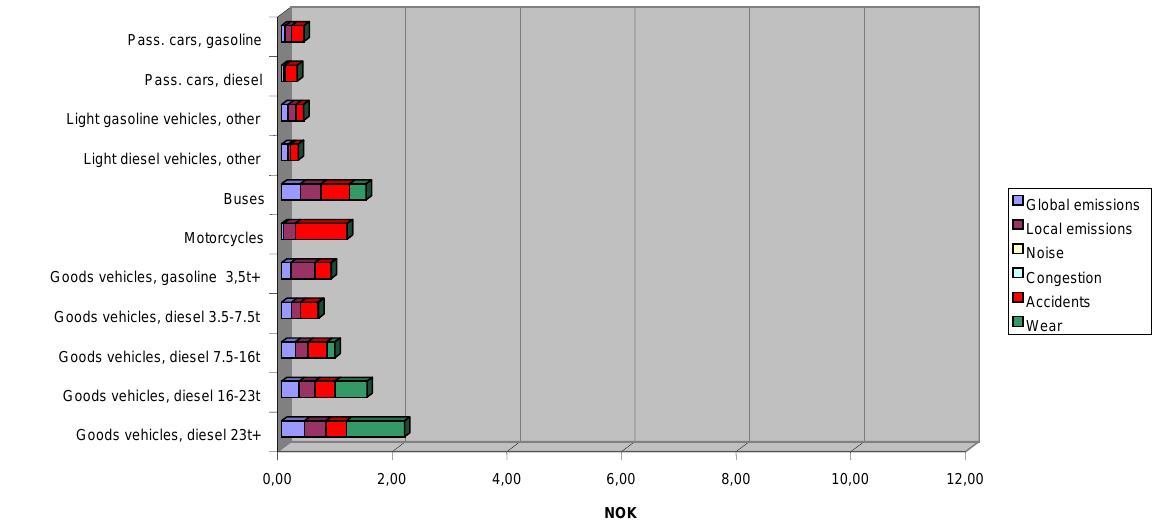
Figure 7. Marginal external costs per vehicle km. Rural